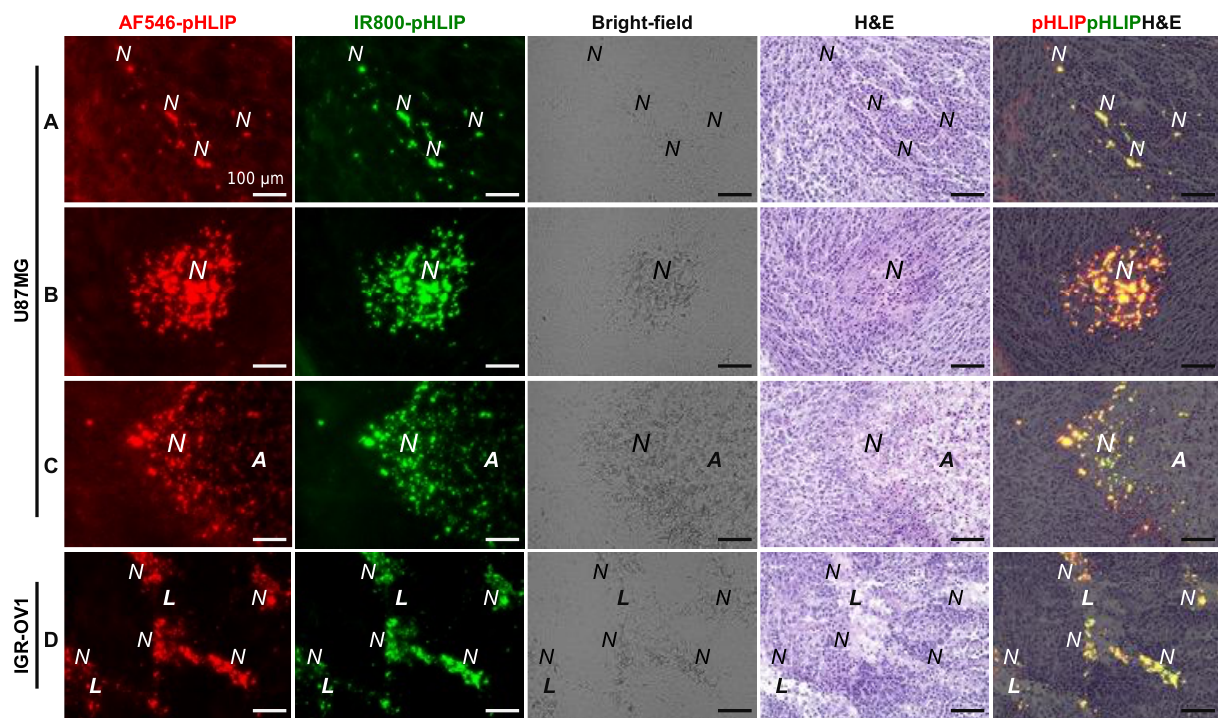
Figure 3. The intratumoral distribution (ITD) of pHLIP in different sites of U87MG ( A – C ) or IGR-OV1 tumors ( D ). The images of pHLIP distribution (AF546-pHLIP, red; IR800-pHLIP, green) are displayed in parallel with the corresponding bright-field images and hematoxylin and eosin-stained specimens at the same sites in the same sections. Yellow color in the rightmost panels ( A – D ), red/green overlapping. N , necrotic region; A , amorphous mass of necrotic material; L , liquefactive mass of necrotic material.